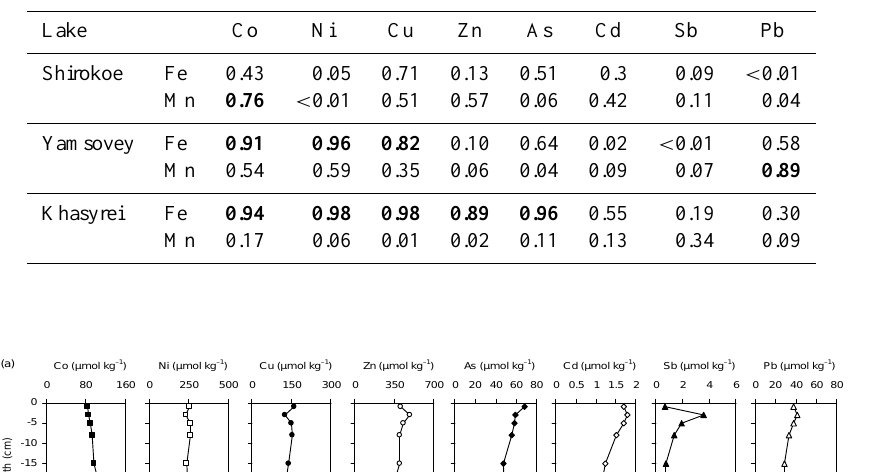
Table 3. Correlation coefficients ( R 2 ) between particulate trace elements and Fe and Mn in the sediments of Lake Shirokoe, Lake Yamsovey and Lake Khasyrei.